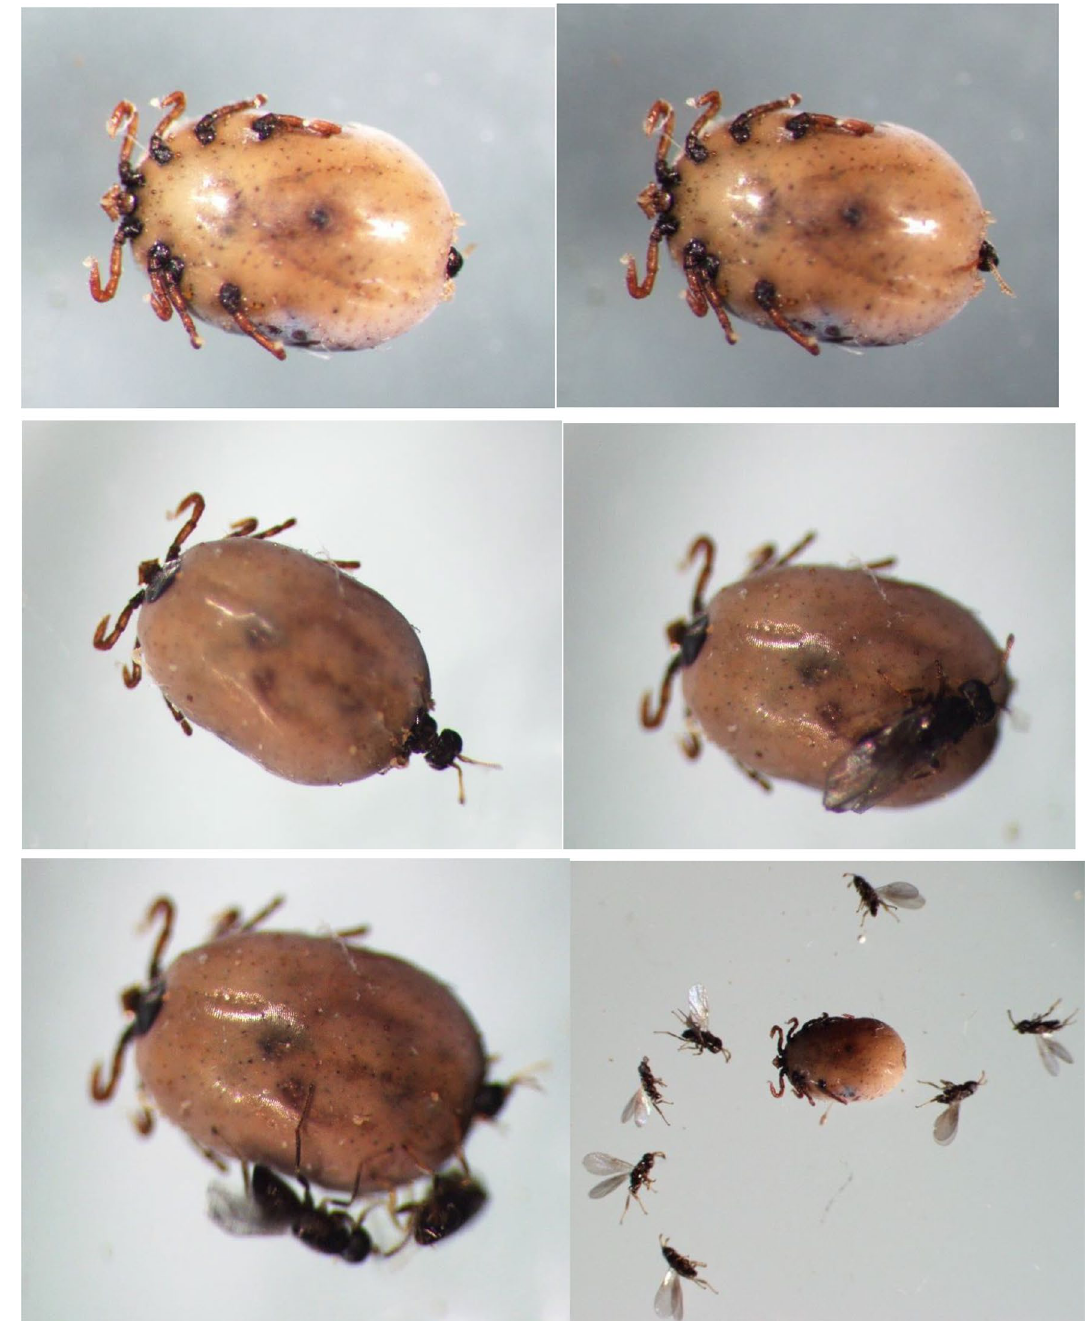
Figure 1. Emergence of endoparasitoid wasps Ixodiphagus hookeri from Haemaphysalis concinna